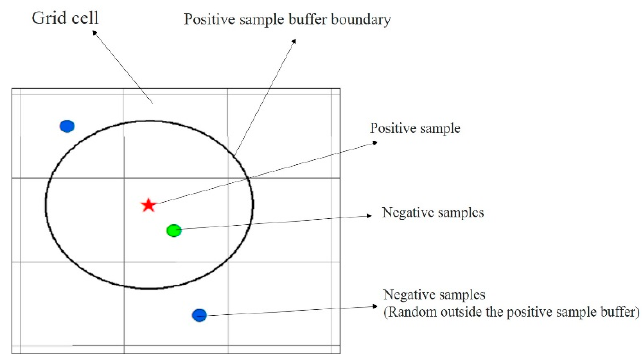
Figure 6. Schematic diagram of negative samples space sampling based on positive